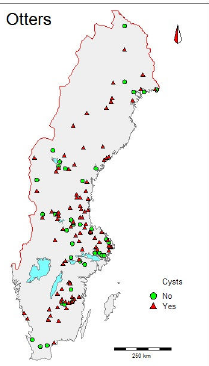
Figure 2. Map of Sweden, showing finding sites of dead otters ( Lutra lutra ) with one or more cysts on the spermatic ducts (red triangles) and otters without any cysts (filled green circles).